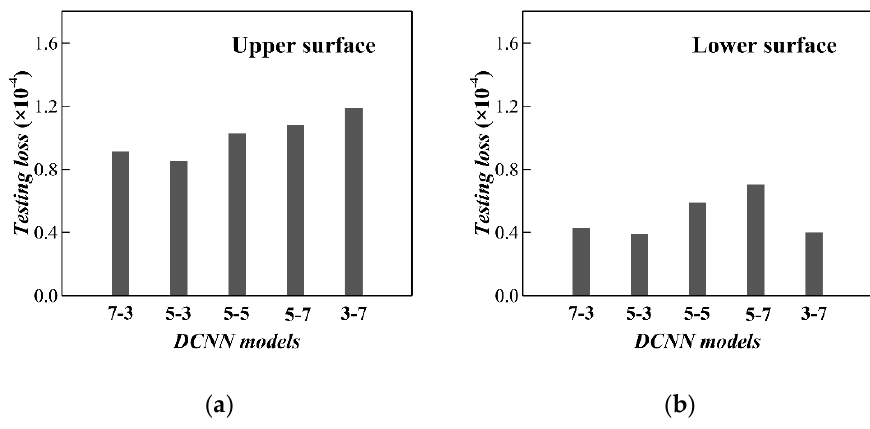
Figure 8. Testing loss of DCNN model for ( a ) upper surface and ( b ) lower surface.